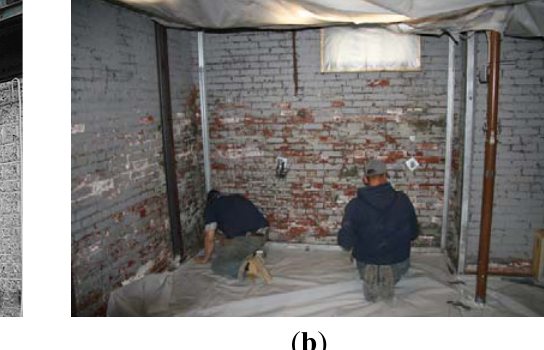
Figure 30. Shotcrete repair: ( a ) Concrete wall in a factory; ( b ) Clay masonry walls in a basement before repair; ( c ) After